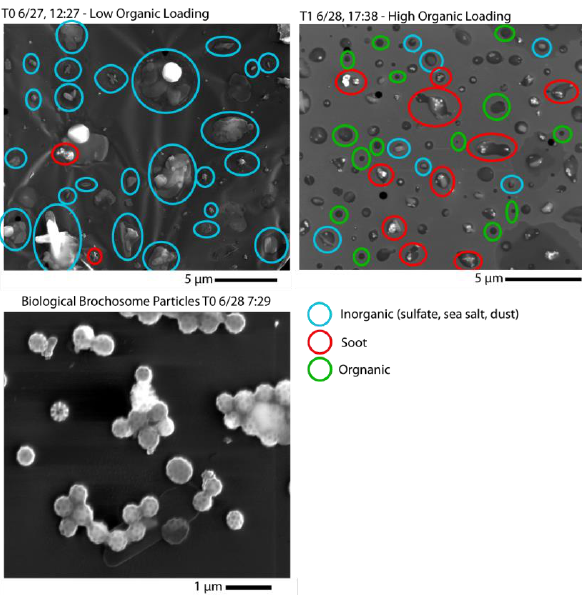
Fig. 5. (Top) Representative SEM images of particles sampled at T0 and T1 during periods of low (T0, 27 June, 12:27) and high (T1, 28 June, 14:29) organic aerosol loading. (Bottom) An image of biological (brochosome) particles commonly observed during the CARES study.